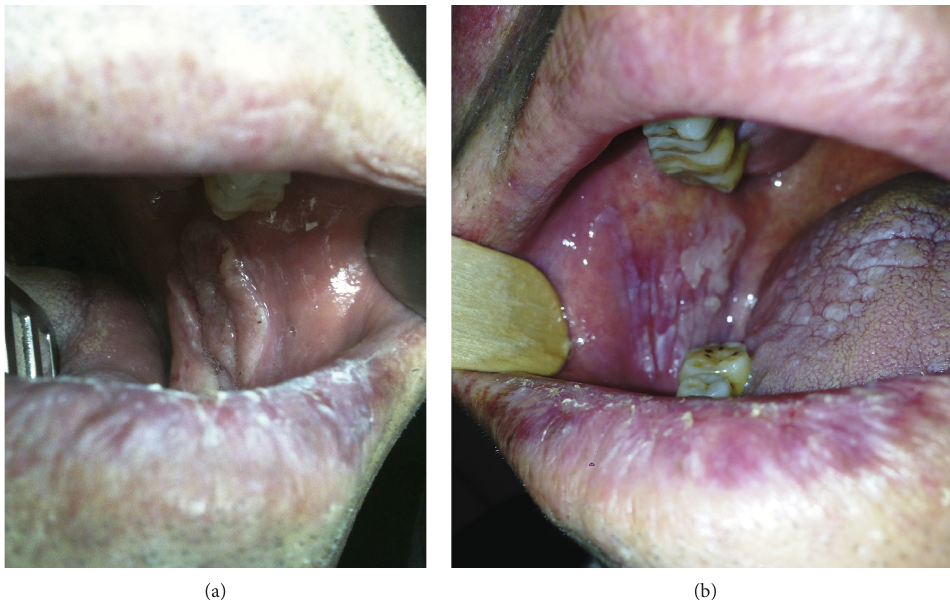
Figure 1: (a) Exophytic tumor with a smooth whitish surface on the left buccal mucosa. (b) Lichen planus in the right buccal mucosa and on the tongue; actinic cheilitis is also seen on the